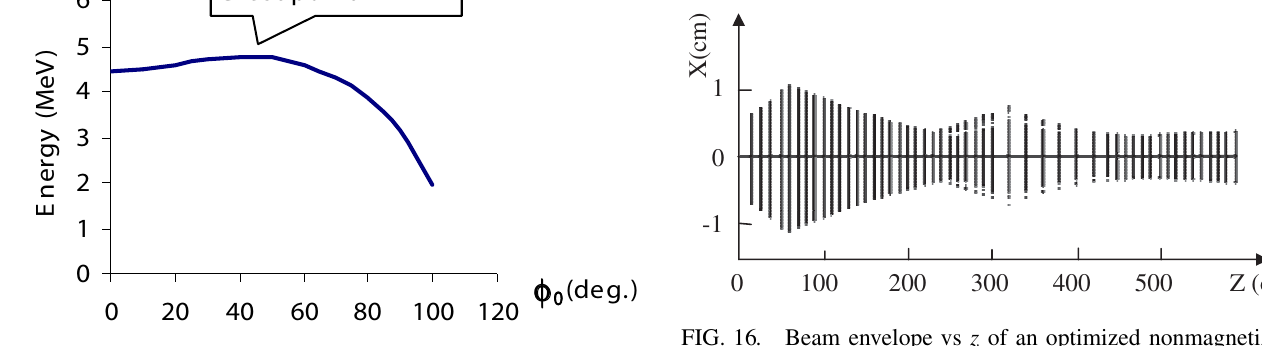
FIG. 15. Electron energy as a function of initial phase (cid:9) TABLE I. Parameters predicted by theory and the results of optimization.